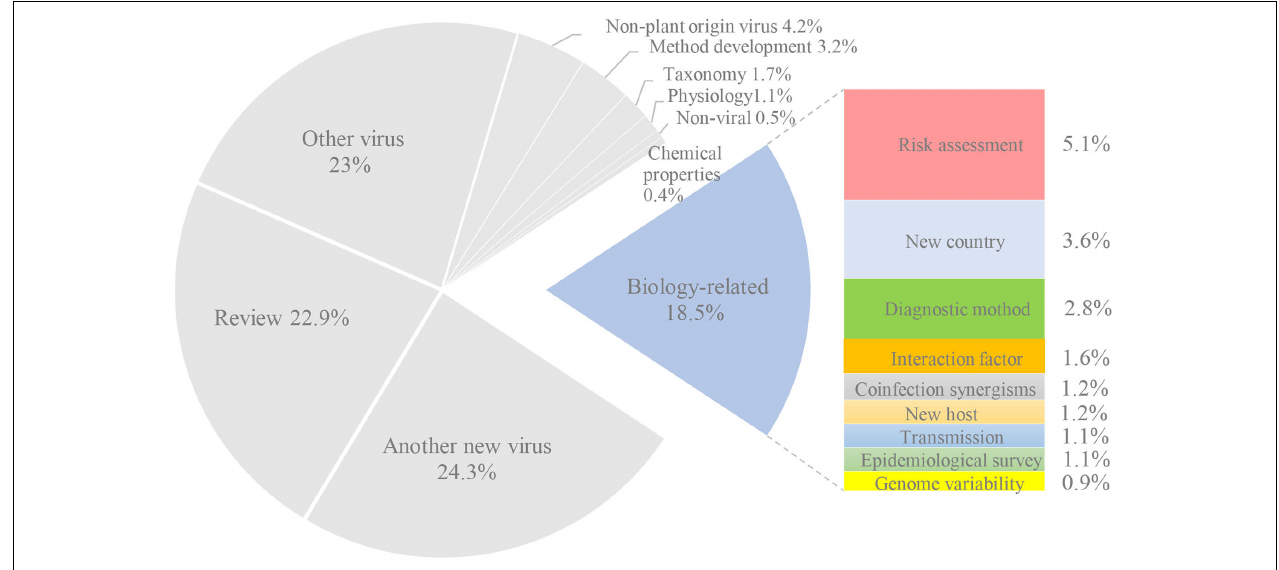
FIGURE 2 | Publications citing a new fruit tree viral